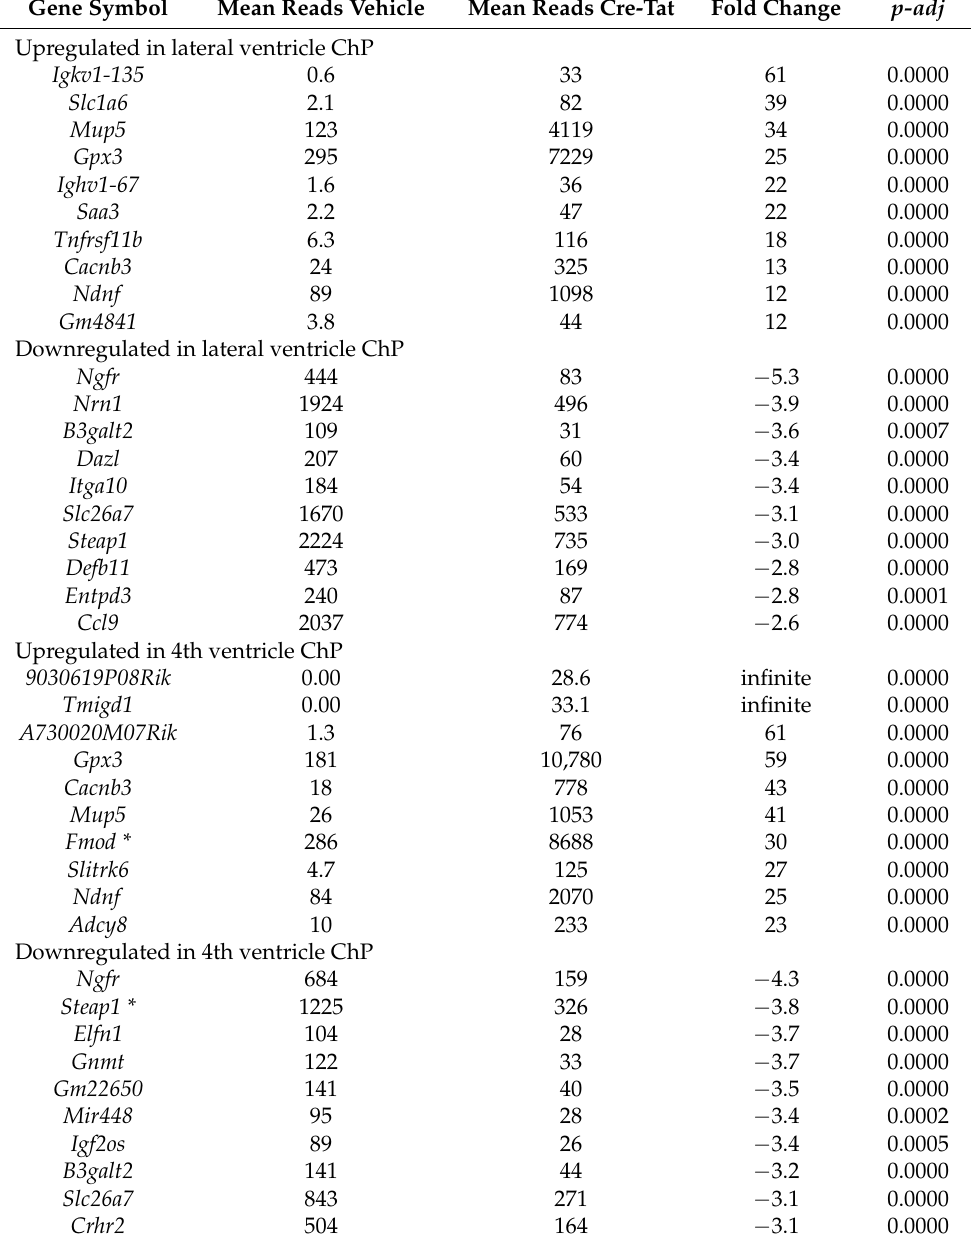
Table 2. Top 10 differentially expressed genes in choroid plexus of Cre + Otx2 lox/lox mice. Genes in fourth ventricle with * are also deregulated upon embryonic Otx2 knockdown in the hindbrain choroid plexus